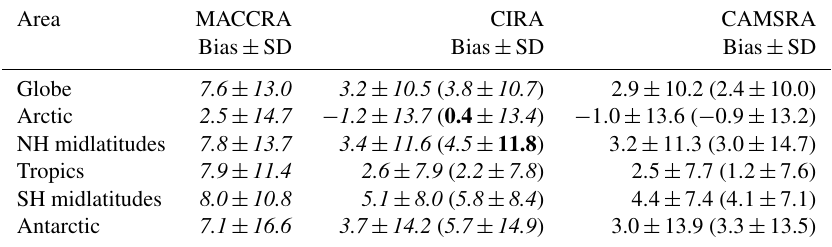
Table 3. Mean biases and standard deviations from MACCRA, CIRA and CAMSRA relative to WOUDC Dobson data (shown in Fig. 8) in DU. The values are calculated for the period 2003–2012, and the values in brackets are calculated for CIRA and CAMSRA for the period 2003–2016. Numbers in italics mark where MACCRA or CIRA have larger biases or standard deviation than CAMSRA, and numbers in bold mark where their values are